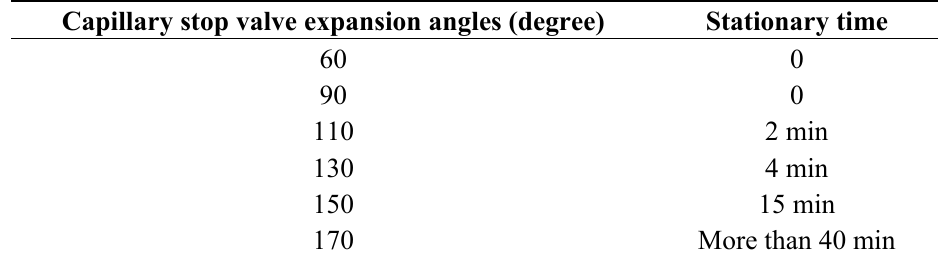
Table 2. The fluid stationary time for the stop valves with six different expansion angles and the PEO-PDMS cover in the 0.4% PEO concentration